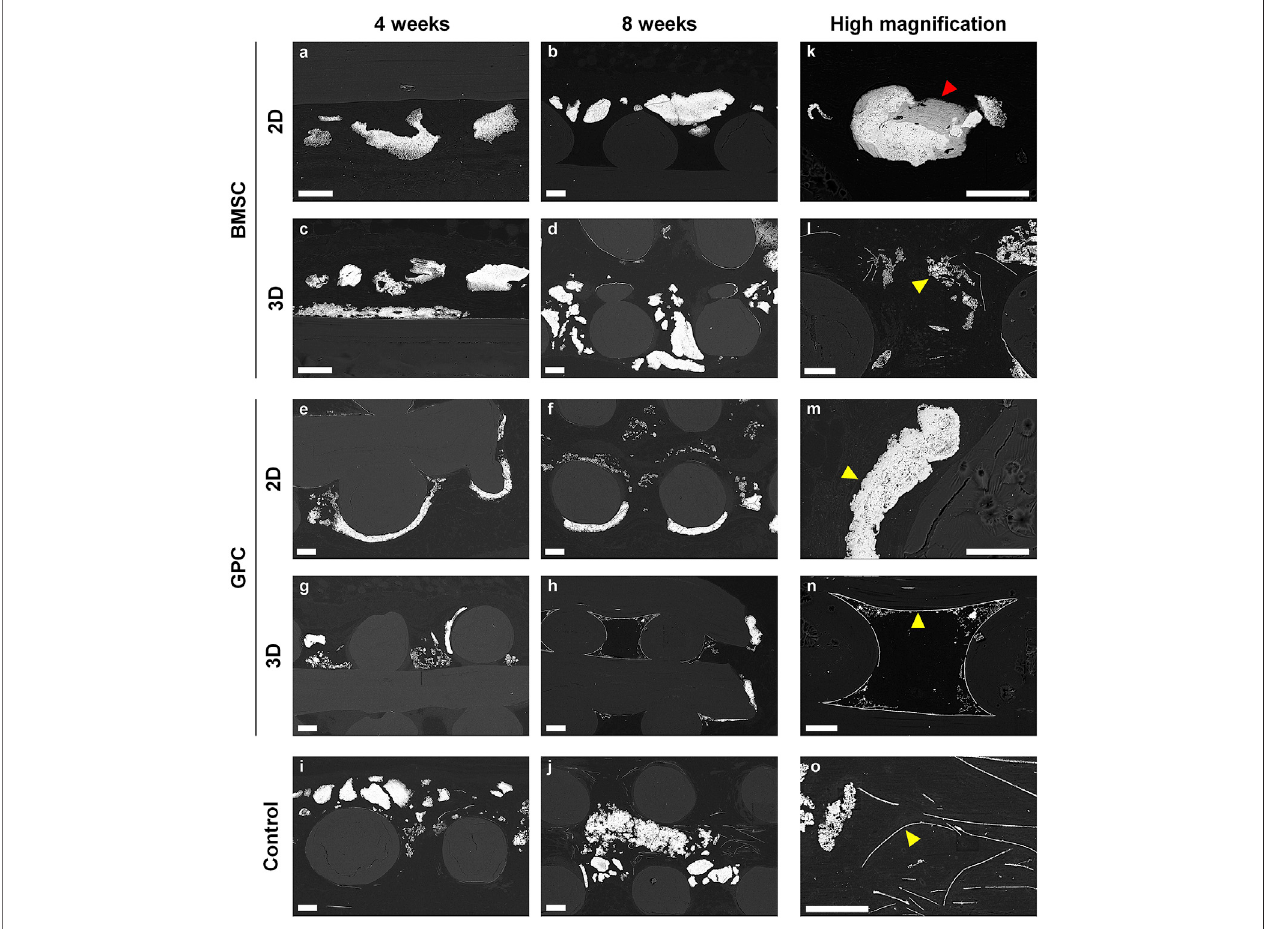
FIGURE 8 | SEM analysis. (A – J) Representative images of BMSC, GPC and control constructs (no cells) after 4 and 8 weeks. (K – O) Corresponding high magni fi cation images from each group; yellow arrows indicate the different patterns of mineralization: (K,M) sheet/plate, (L) globular, (N,O) fi lament-like; red arrow indicates the only instance of “ bone-like ” tissue observed in the study; scale bars 100 μ